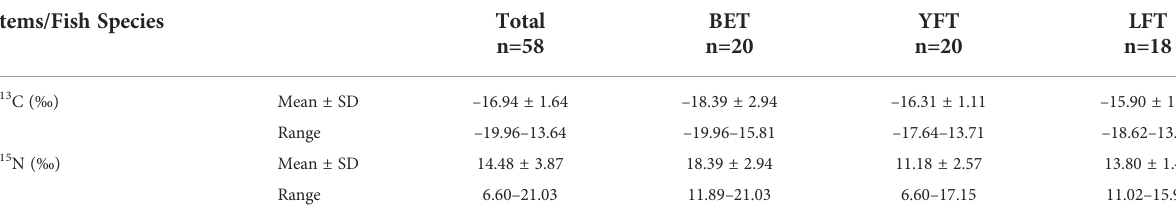
TABLE 4 Comparison of stable isotope differences among three species of